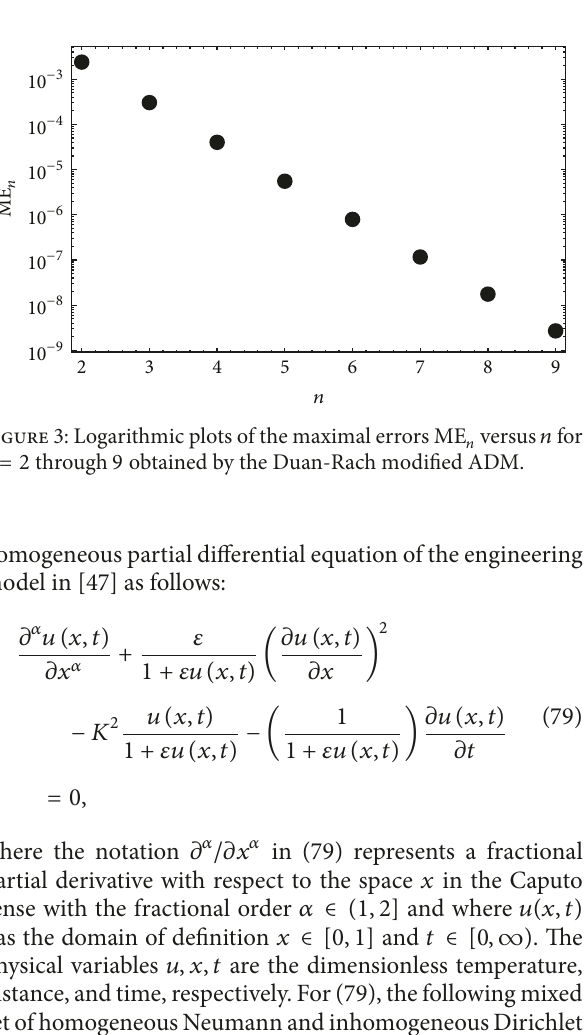
Figure2:ER 𝑛 (𝑥) when 𝑛 = 10 obtainedbytheDuan-Rachmodified ADM for 𝛼 = 1.2 (dot-dash), 𝛼 = 1.4 (dot line), 𝛼 = 1.6 (dot-dot- dash), and 𝛼 = 1.8 (dash line).